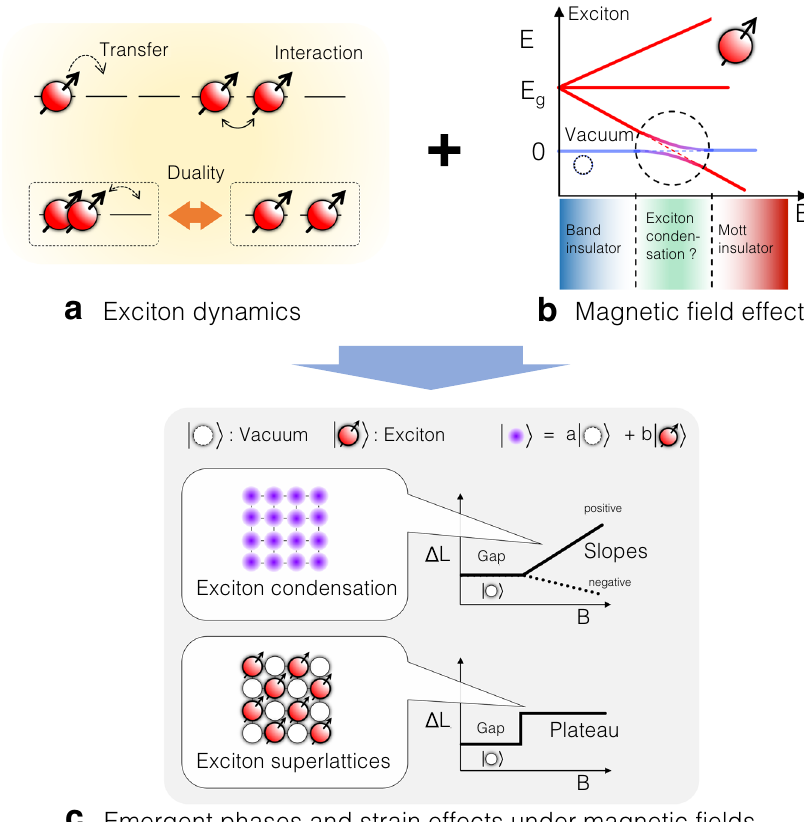
Fig. 2 | Schematic illustrations describing the possible occurrence of exotic orderings of excitons in LaCoO 3 under high magnetic fi elds. a Schematic drawing of the interactions and dynamics of the excitons. b Schematic drawing of